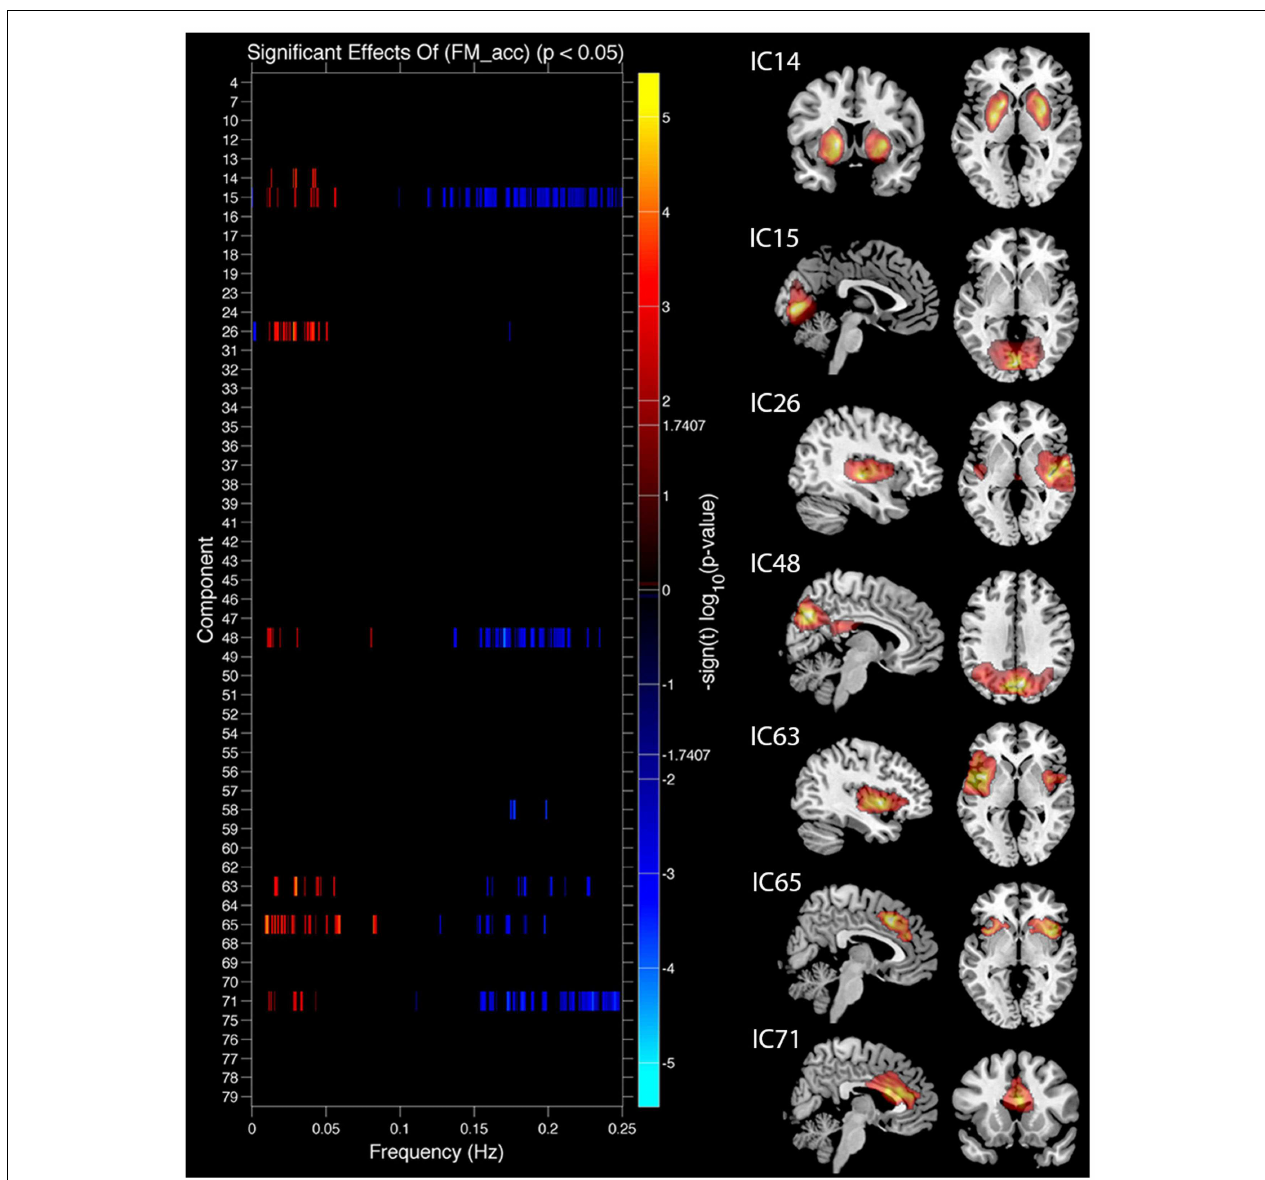
(greater spectral power with lower accuracy), black indicates their was no significant difference after correcting for multiple comparisons. Right column shows spatial maps for components which showed a significant relationship with face match accuracy. All results are FDR thresholded ( p <